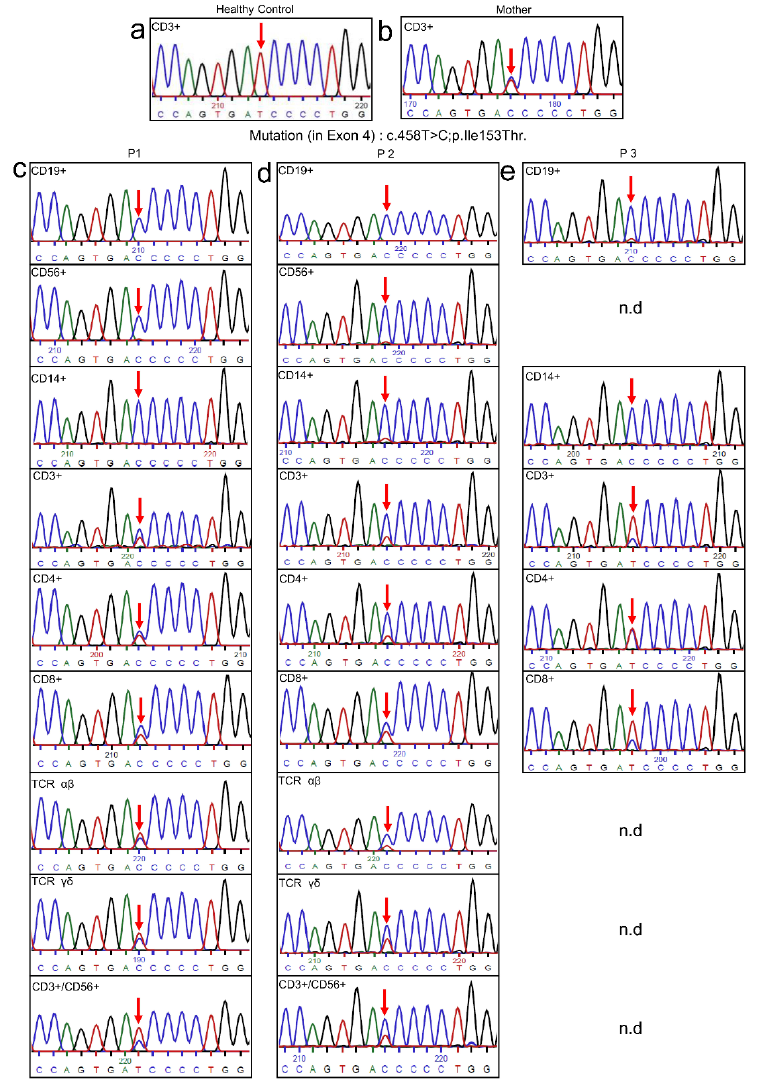
Figure 3. Gene sequence analysis was shown for CD3 + T cells of healthy control ( a ), CD3 + T cells of patients’ mother (which also presented the mutation) ( b ), and various lymphocyte subsets sorted from patients’ PBMCs ( c , d , e ): CD19 + B cells, CD56 + NK cells, CD14 + monocytes had the mutation, while CD3 + , CD4 + , CD8 + , αβ , γδ T cells and NKT (CD3 + /CD56 + ) cells have a reverted mutation (n.d = not determined due to lack of patient’s